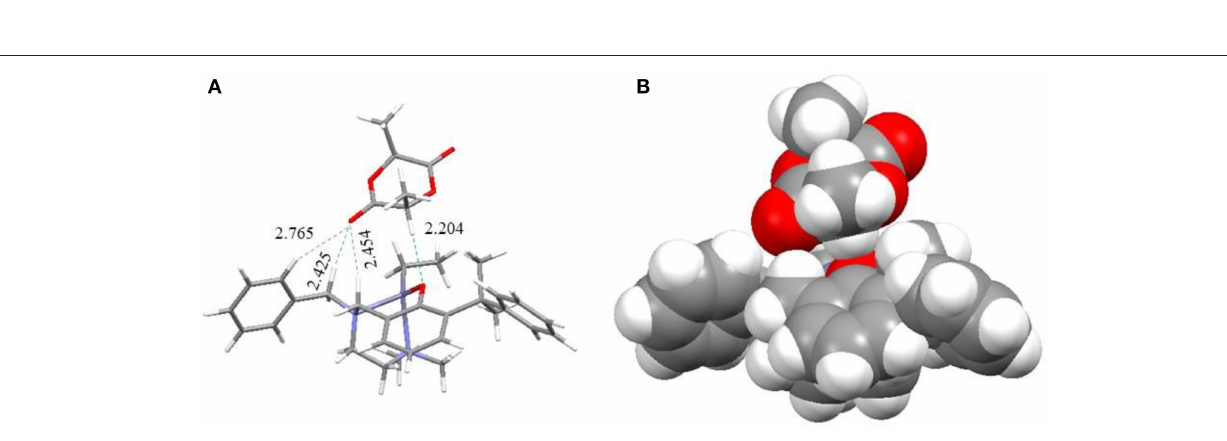
FIGURE 10 | Mechanism of L -lactide polymerization with N,N,O -tridentate aminophenolate Zn complexes as catalysts and benzyl alcohol as an initiator.